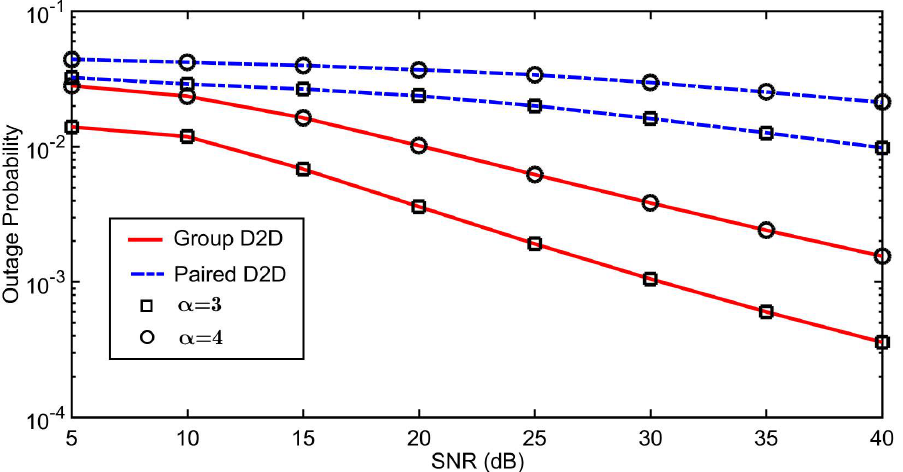
Figure 4. Outage comparison between paired and group